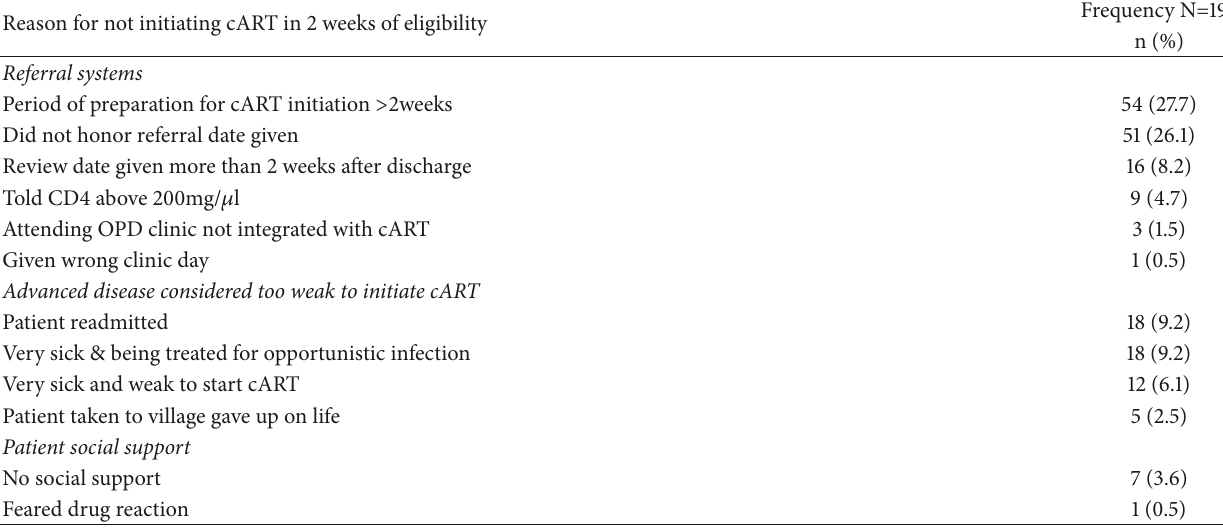
Table 3: Reasons for delayed initiation of cART among HIV-infected cART-na¨ıve adults hospitalized at Mulago hospital. Reason for not initiating cART in 2 weeks of